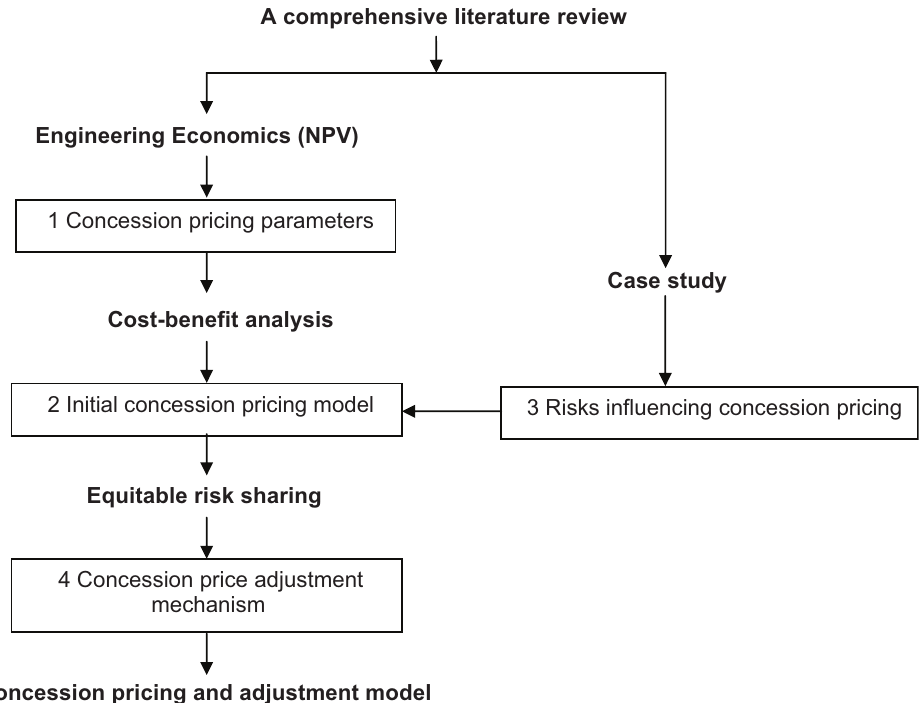
figure 2. The research flow of concession pricing and adjustment model for PPP highway